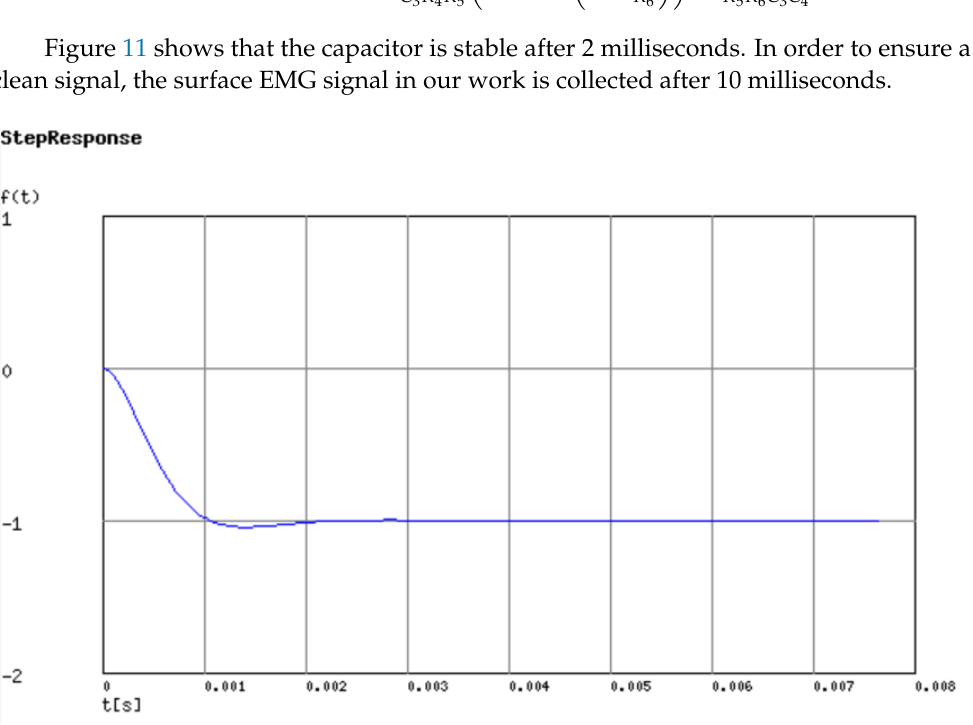
Figure 11. Transient analysis of the proposed MFB filter.